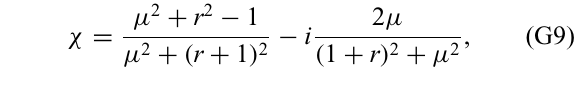
FIG. 13. (a) Central spin model realized by Rydberg-dressed atoms (red) interacting with ancilla qubit encoded on a ground- to-Rydberg transition (blue). (b) Central boson model realized by driving one-sided cavity coupled to system spins and heralding on